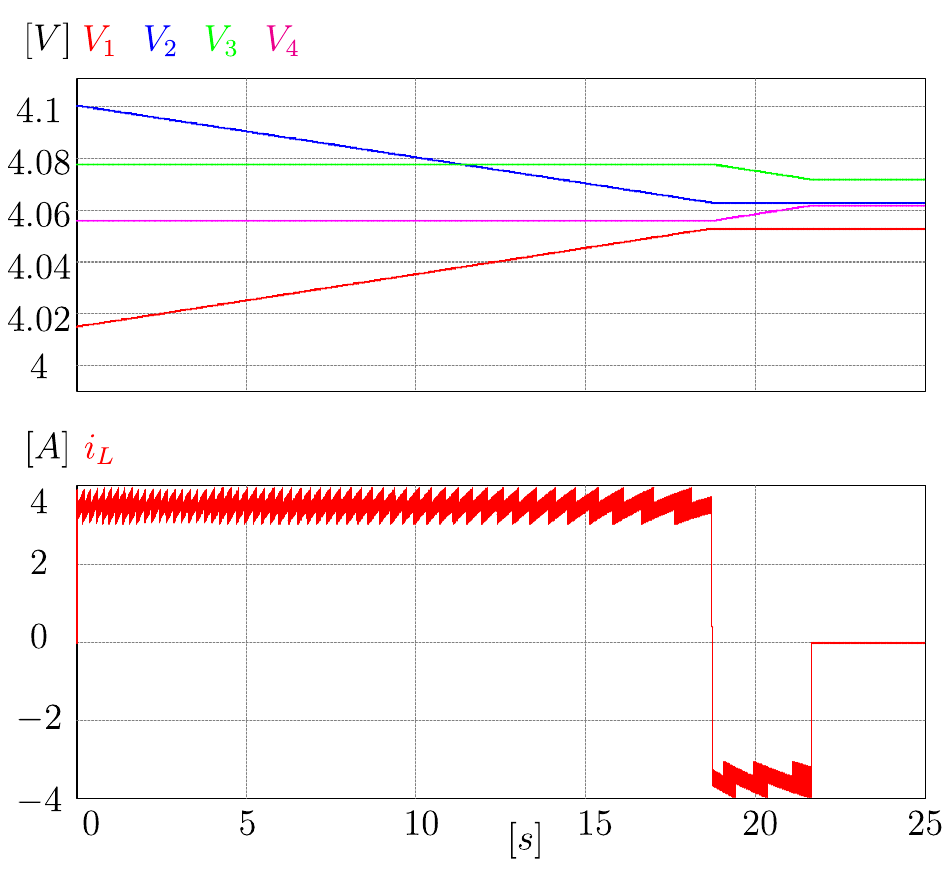
Figure 16. Simulation results for the equalization process with the same conditions of the work